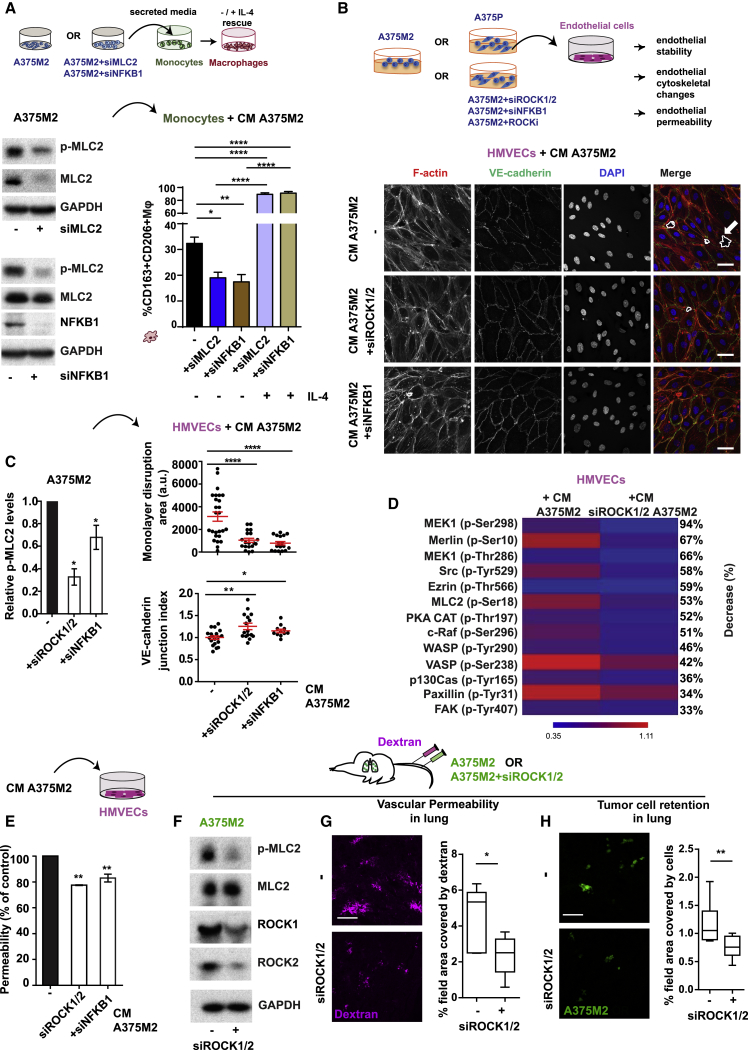
NF-κB Cross-Talk with ROCK-Myosin II in Amoeboid Melanoma Cells Educates the Tumor Microenvironment(A) (Top) Schematic: macrophage phenotypes after indicated treatments. (Bottom left) Immunoblots for p-MLC2 after MLC2 or NFKB1 knockdown in A375M2 cells. (Bottom right) Percentage of CD163+CD206+ macrophages upon treatment of PMBC-derived monocytes with CM from NFKB1-depleted or MLC2-depleted A375M2 cells, ±IL-4 (n = 4).(B) (Top) Schematic: treatment of endothelial cells with indicated conditions and downstream assays. (Bottom) Confocal images of VE-cadherin (green), F-actin (red), and DAPI (blue) immunostaining in HMVECs after indicated treatments. Dashed white lines represent gaps. Scale bar, 40 μm.(C) (Left) Relative p-MLC2 levels in indicated conditions (n ≥ 3). (Top right) Quantification of monolayer disruption area and (bottom right) VE-cadherin junctional index in HMVECs after indicated treatments (n ≥ 2).(D) Heatmap shows fold change in expression of proteins regulating endothelial permeability in HMVECs treated with CM A375M2 ± siROCK1/2. Blue and red show the highest and the lowest expression levels, respectively (6 replicates/antibody).(E) Permeability (versus the control) in HMVECs treated with indicated conditions (n ≥ 3).(F) Immunoblots for p-MLC2, ROCK1, and ROCK2 of A375M2 ± siROCK1/2.(G) (Left) Confocal images of mouse lungs after tail vein injection of 5-chloromethylfluorescein diacetate (CMFDA)-Green labeled A375M2 ± siROCK1/2 and dextran (purple) and (right) percentage of field area covered by dextran (20 fields/mouse/condition).(H) (Left) Confocal images of mouse lungs from (G) and (right) percentage of field area covered by cells (20 fields/mouse/condition).Scale bar in (G) and (H), 100 μm. In (G) and (H), n = 5 mice/condition for each experiment, n = 2 independent experiments. In (A), (C), and (E), graphs and dot blots show mean ± SEM. In (G) and (H), boxplots show min to max values. In (A), (C), and (E), one-way ANOVA and Tukey post hoc test are shown. In (G) and (H), t test is shown. ∗p < 0.05, ∗∗p < 0.01, ∗∗∗∗p < 0.0001.See also Figure S7.